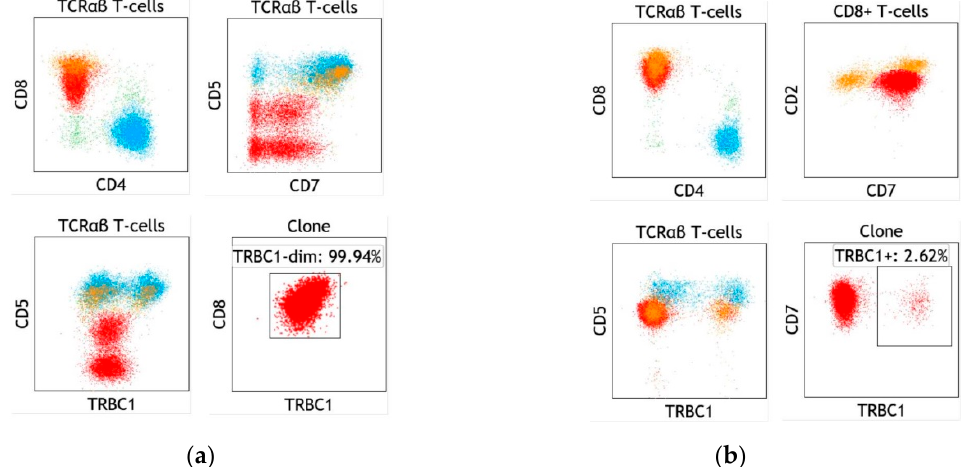
Figure 3. Examples of T-cell large granular lymphocytic leukemia (T-LGLL), showing an expanded CD8-positive T-cell subset with a clonal TRBC1 staining pattern. ( a ) Classic example of T-LGLL in a bone marrow aspirate, characterized by a dominant CD8-positive T-cell population (red) with an aberrant dim expression of CD8 and diminished to negative CD5 and CD7 expression. Monophasic TRBC1-dim expression on both the CD5-dim and CD5-negative subsets is consistent with a single large clonal population. ( b ) A case of T-LGLL in a bone marrow aspirate, lacking conspicuous immunophenotypic abnormalities. The flow cytometry findings are characterized by a dominant CD8-positive subset (red) with discrete clustering on a CD2 vs. CD7 dot plot and a clonal TRBC1-negative expression pattern. In addition, shown are polytypic CD4-positive (cyan) and CD8-positive (orange) T cells and other non-gated events (green). TCR αβ T cells were gated by the exclusion of TCR γδ positivity.